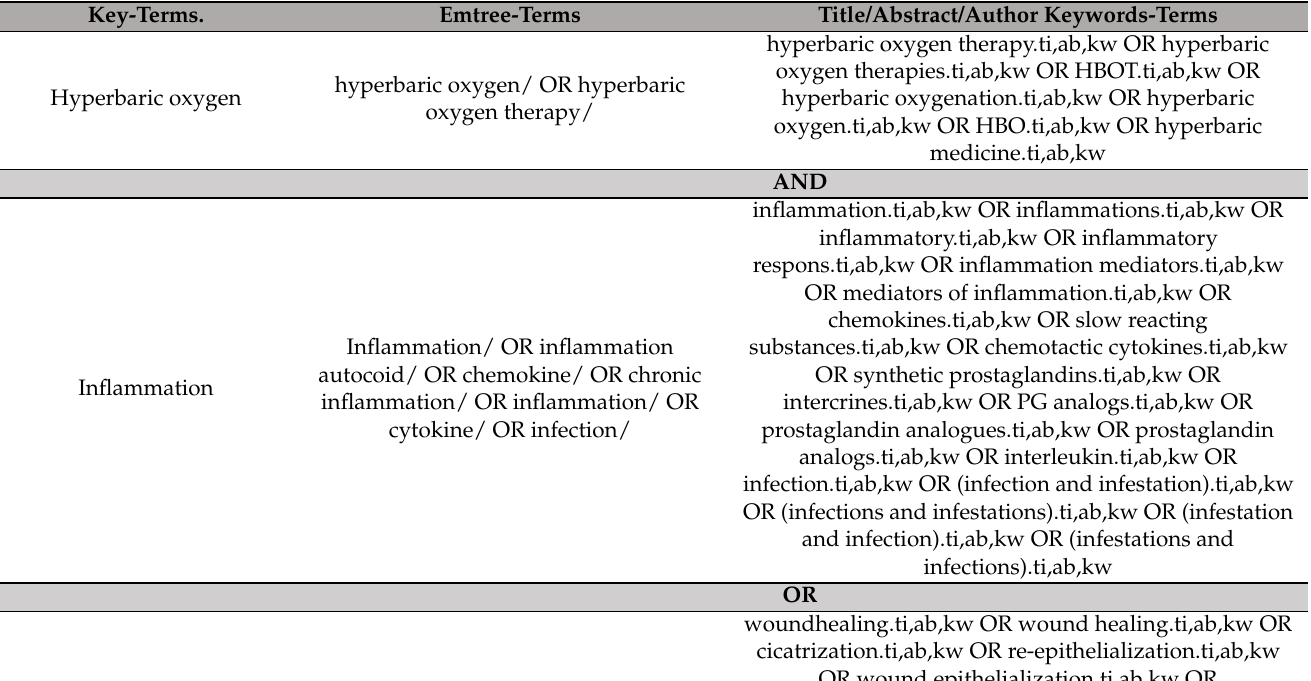
Table A2. Search strategy used in Ovid